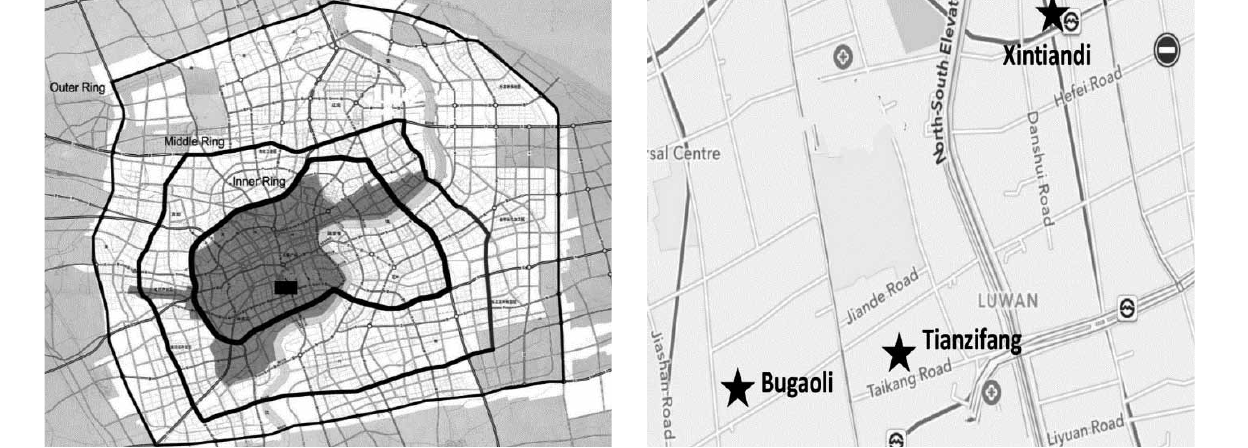
fig. 2. locations of three heritage preservation projects Source: Drawn by the first